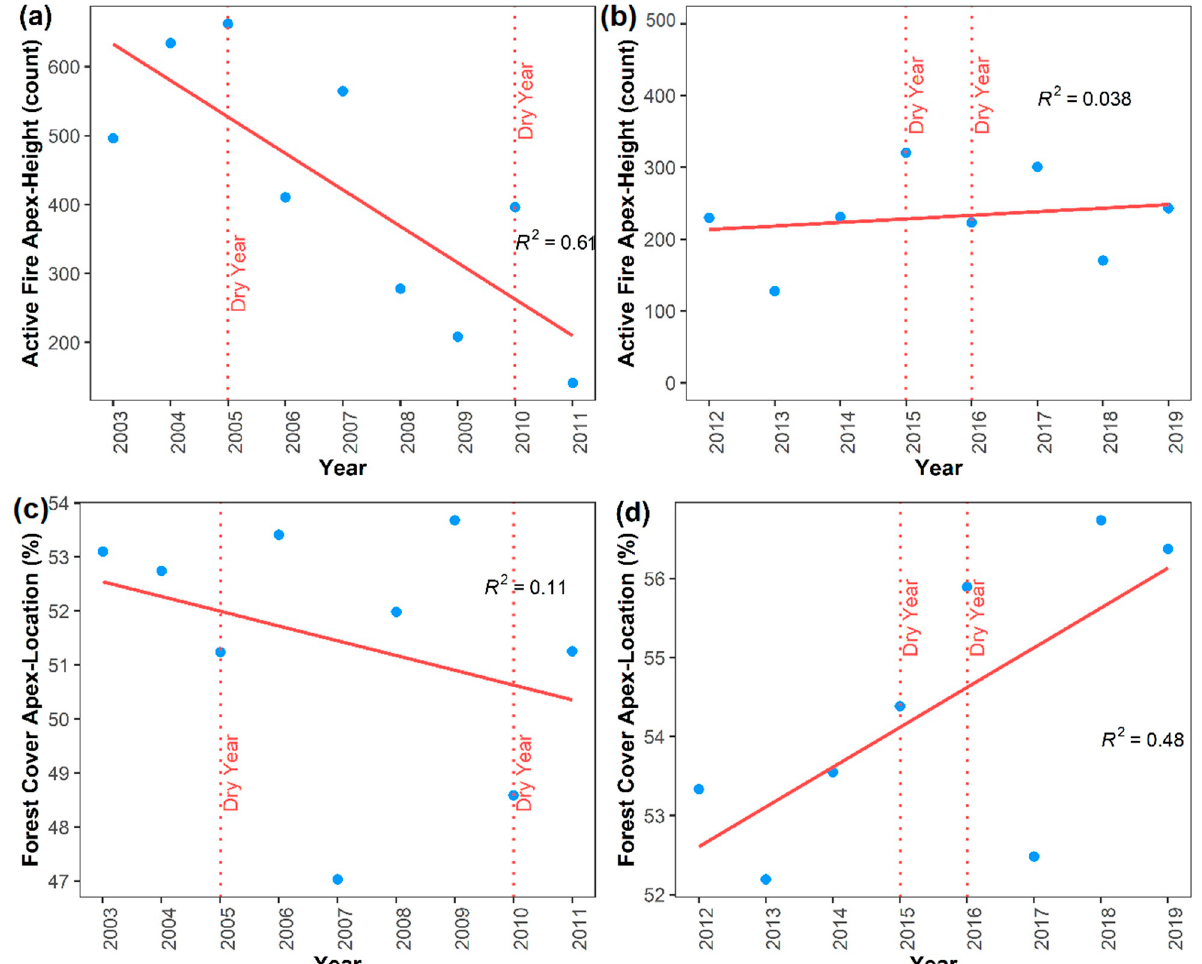
Figure 5. Apex-height and apex-location behaviour in the two analysed periods. ( a ) Active fire apex- height from 2003 to 2011. ( b ) Active fire apex-height from 2012 to 2019. ( c ) Forest cover apex-location from 2003 to 2011. ( d ) Forest cover apex-location from 2012 to 2019.